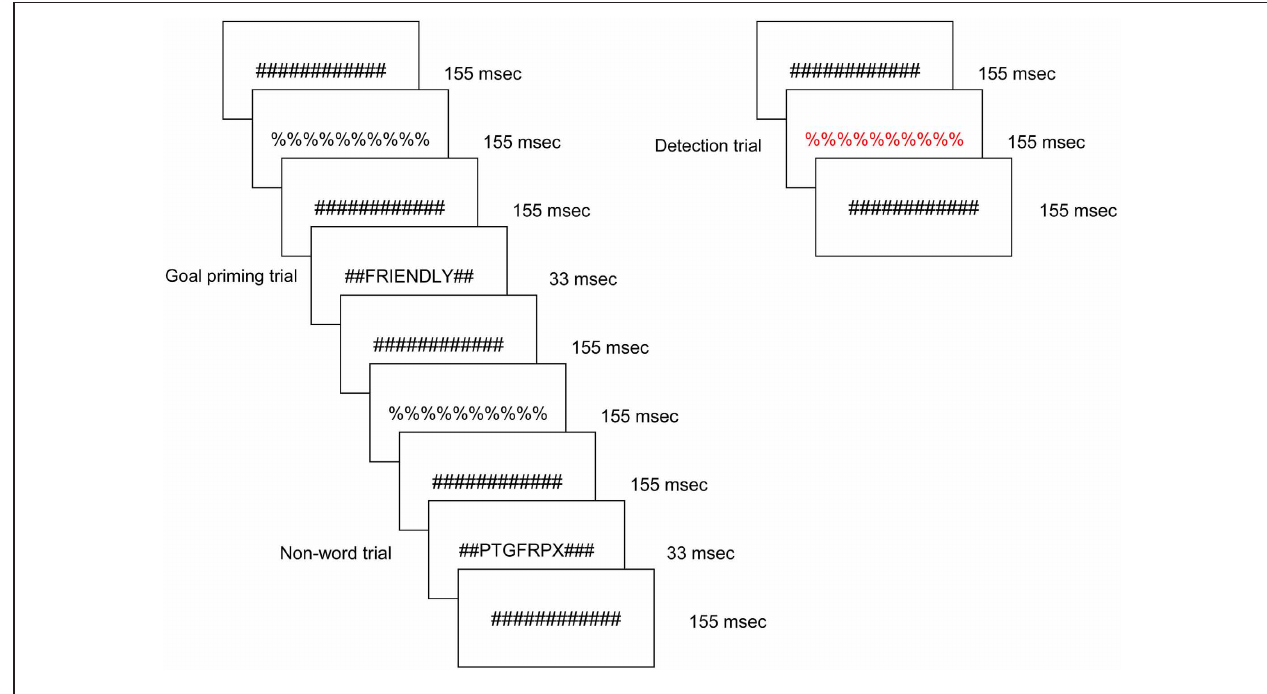
goal, and yoked-control priming stimuli were inserted throughout the run. Incidental to those stimuli visible colored symbol stimuli were displayed to which participants were instructed to respond with a button press as quickly as